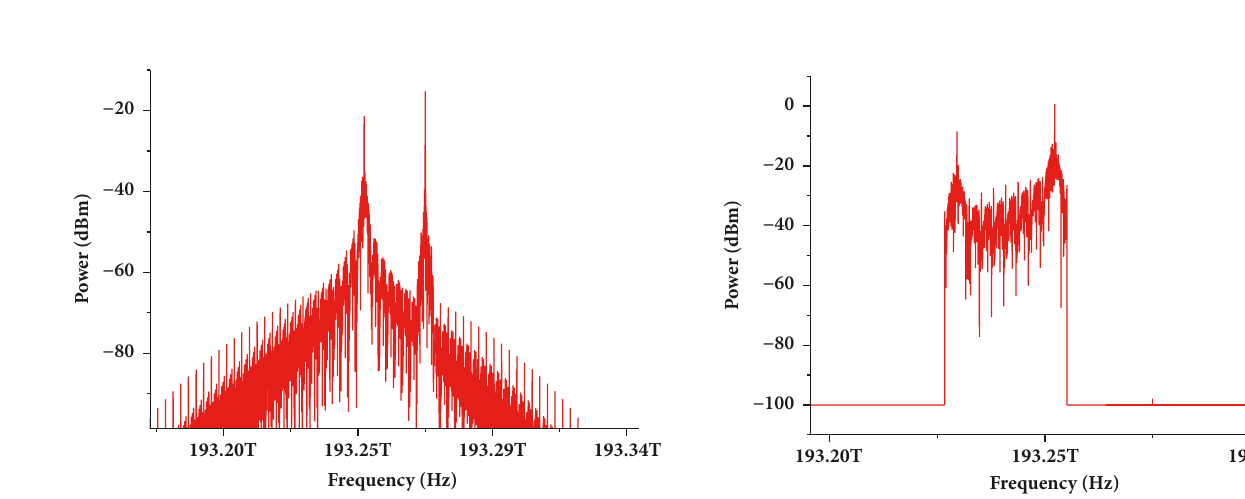
Figure 5: Optical spectrum after SOA.